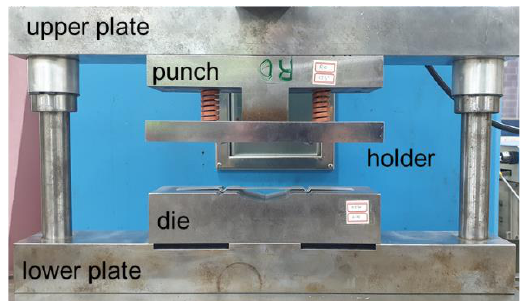
Figure 7. Die set to study the formation process of subtle feature lines.